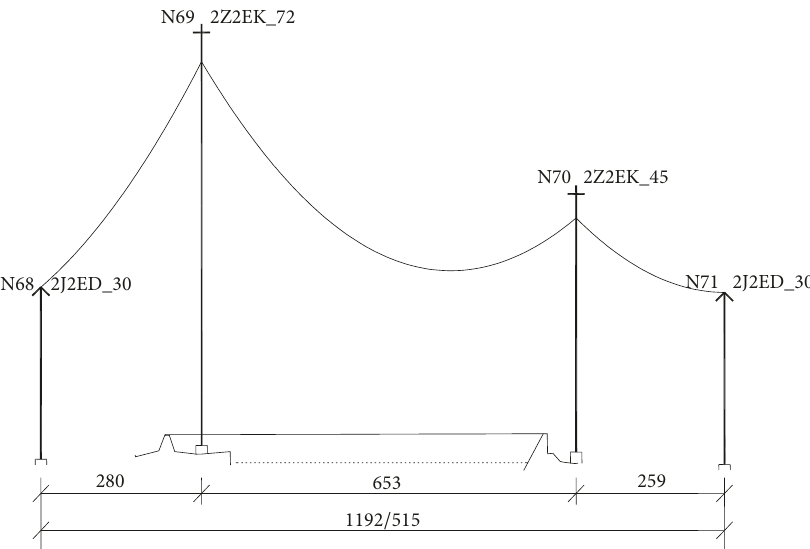
Figure 1: Schematic of the transmission tower-line system crossing a watercourse.